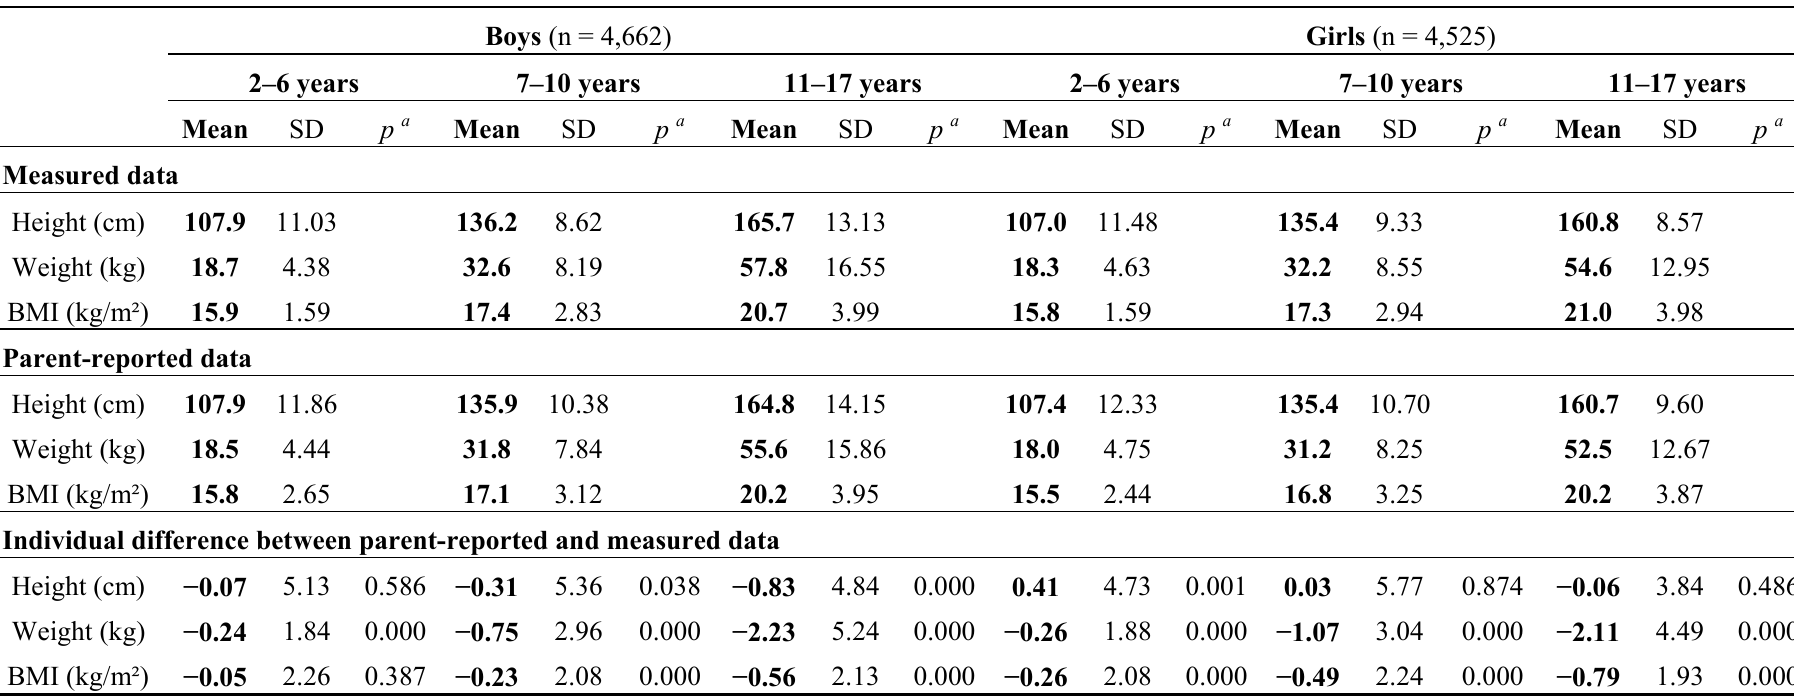
Table 3. Descriptive statistics for measured and parent-reported height, weight and BMI by gender and age